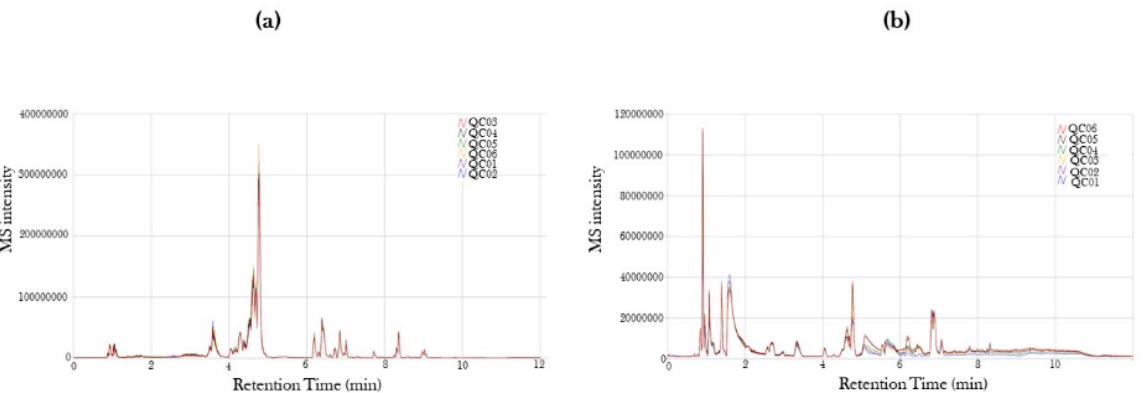
Figure 1. Mass spectra of retention time version ion intensity for COVID-19-positive and COVID-19-recovered patient serum samples. Serum samples from COVID-19-positive and COVID-19-recovered patients were obtained and the serum metabolites were characterized using ultra-performance liquid chromatography mass spectrometry (UPLC-MS). Mass Spectra from ( a ) positive and ( b ) negative ion modes are represented as the initial quality check to identify individual metabolites.